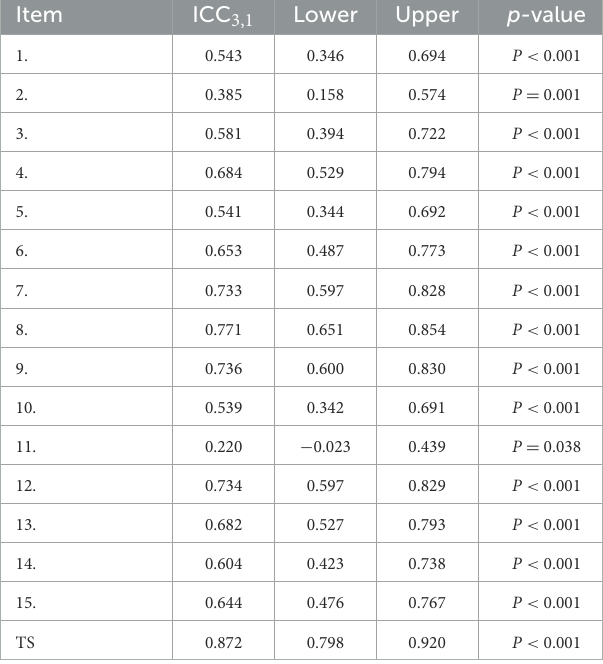
TABLE 2 Test–retest reliability of C-UEFI ( N = 50).